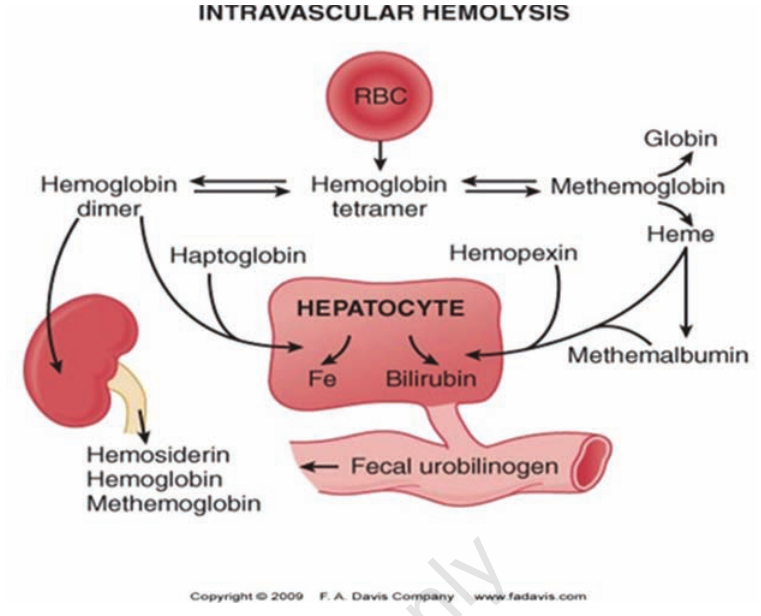
Figure 10. Intravascular destruction of RBCs. 74 Intravascular hemolysis usually occurs when the cell membrane has been severely damaged by any of a number of different mech- anisms, including autoimmune phenomena, direct trauma (e.g., march hemoglobinuria), shear stress (e.g., defective mechanical heart valves), and toxins (e.g., clostridial toxins, venomous snake bite). It results in hemoglobinemia when the amount of Hb released into plasma exceeds the Hb-binding capacity of the plasma-binding protein haptoglobin, a globulin normally present in concentrations of about 1.0 g/L in plasma. With hemoglo- binemia, unbound Hb dimers are filtered into the urine and reabsorbed by renal tubular cells; hemoglobinuria results when reabsorptive capacity is exceeded. Iron is embedded in hemosiderin within the tubular cells; some of the iron is assimilated for reutilization and some reaches the urine when the tubular cells